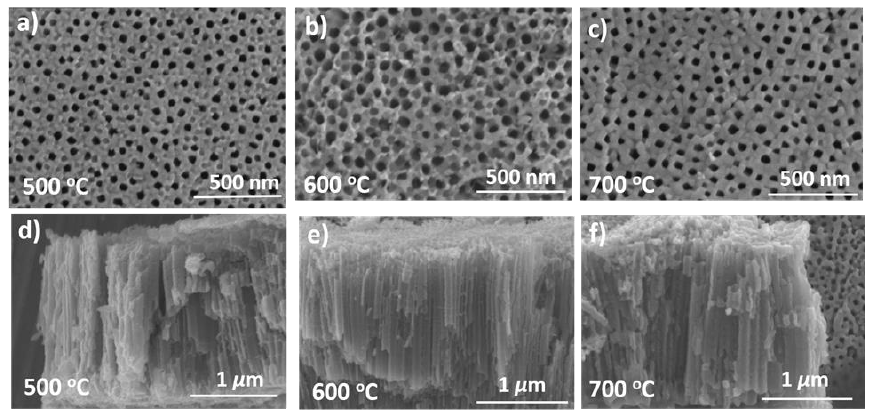
Figure 1. Field emission scanning electron microscope (FESEM) images of TiO 2 nanotubes ( a – c ) top view and ( d – f ) corresponding cross-sectional images.